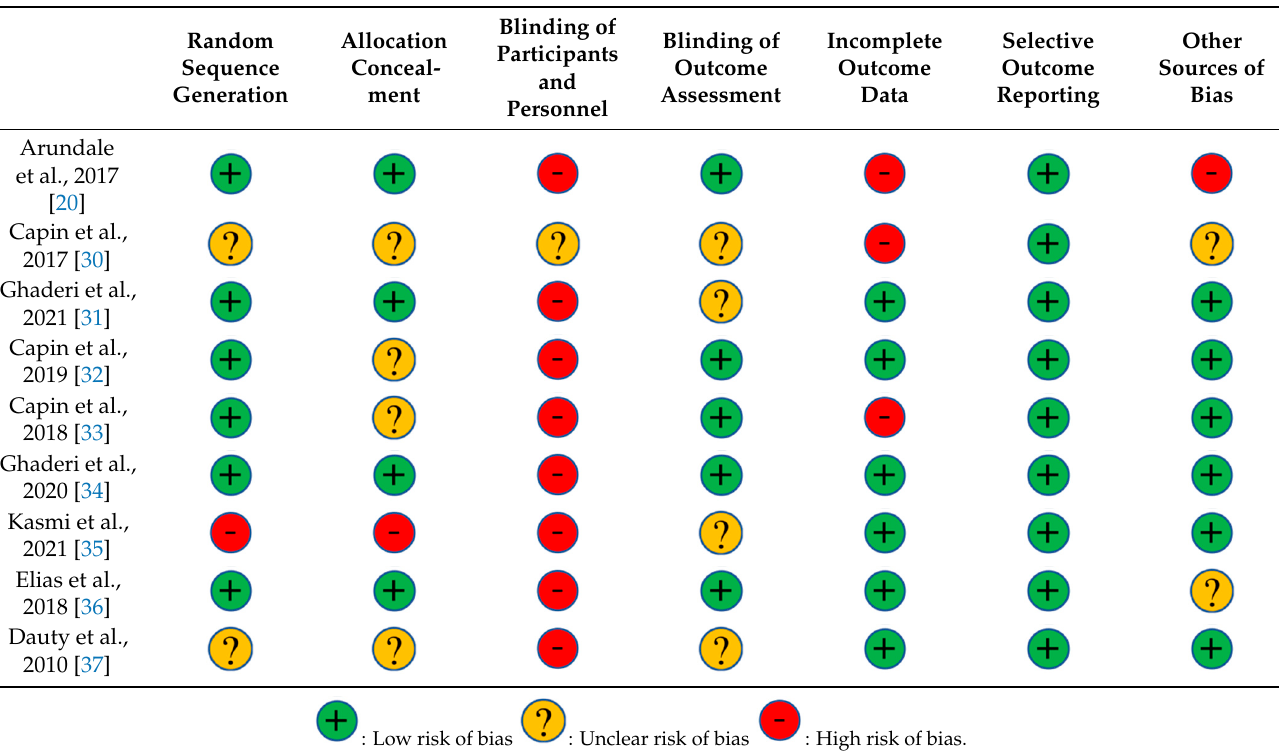
Table 2. The risk of bias assessment of the included studies according to the Cochrane risk of bias framework [28].